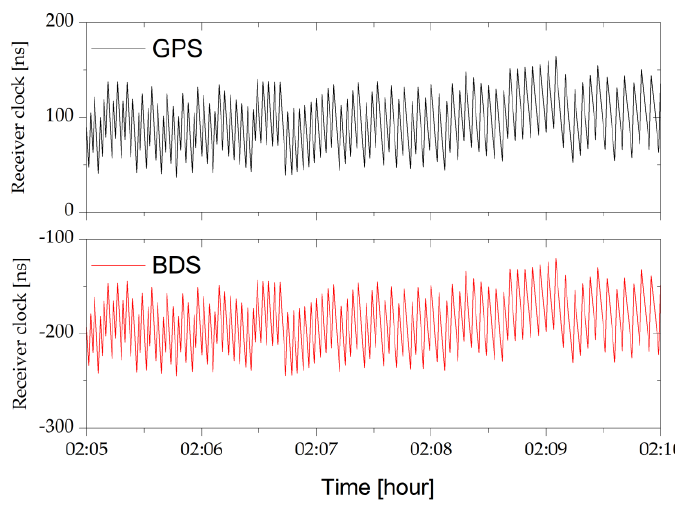
Figure 3. Frequent clock steering events captured in the GPS and BDS receiver clock series. A high-order time difference (HTD) approach based on the carrier phase is capable